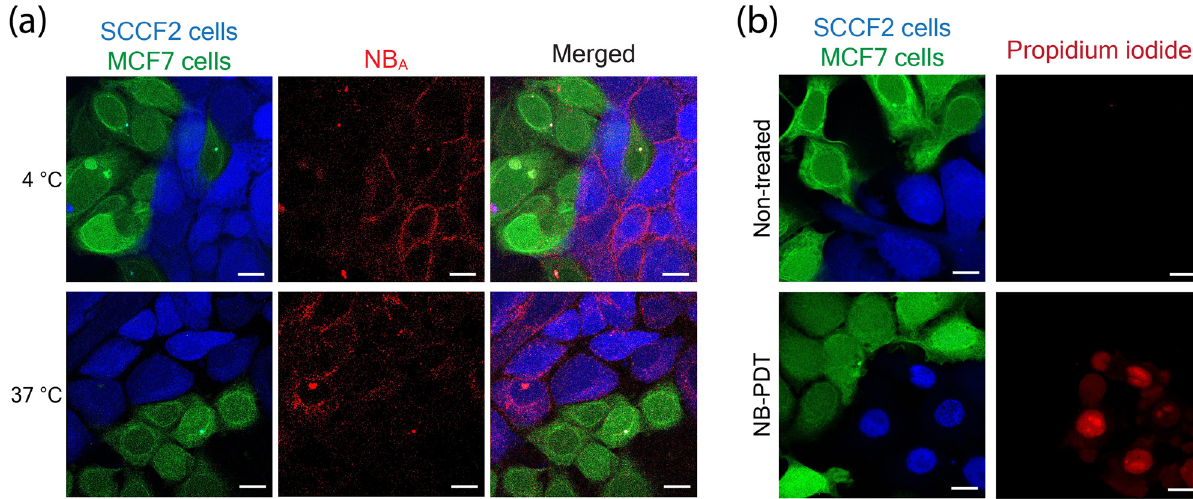
Figure 5: Specificity of NB A and NiBh in cocultures. SCCF2 cells were labeled with ViaFluor 405 (blue), MCF7 cells with ViaFluor 488 (green), and co-cultured in a 1:1 ratio. (a) Confocal images of cells incubated with 50 nM of NB A -Alexa 647 (red) for 1 h at 4 ° C (top) or 30 min at 37 ° C (bottom). Scale bar, 15 µm. (b)Confocalimagesofcells2hafterNB-PDTwith50nMofNiBh.Cellswerestainedwithpropidiumiodidetodistinguishdeadcells(red).Scale bar, 15